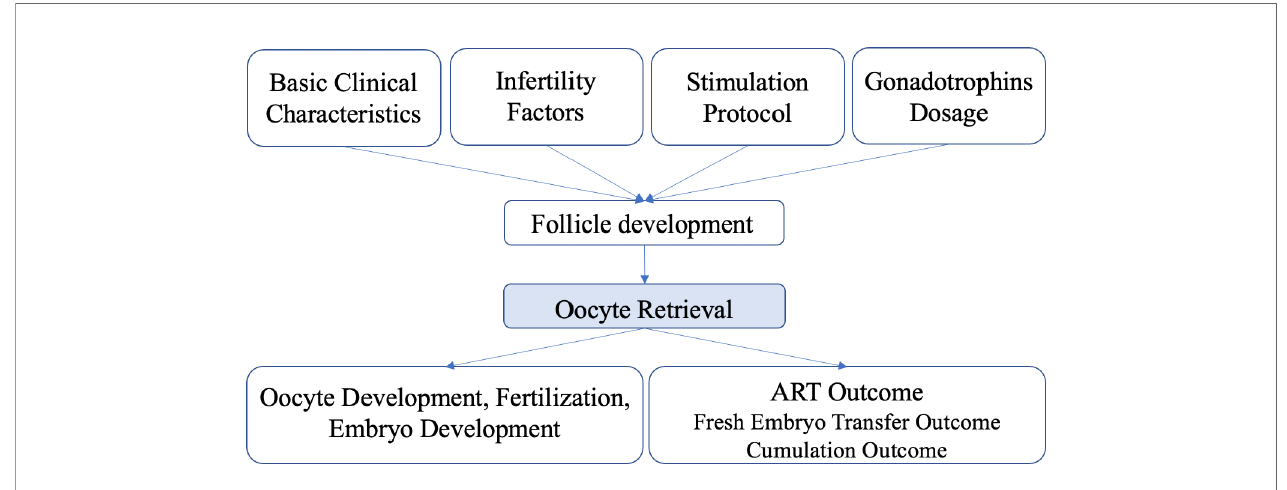
FIGURE 1 | Flowchart of the study